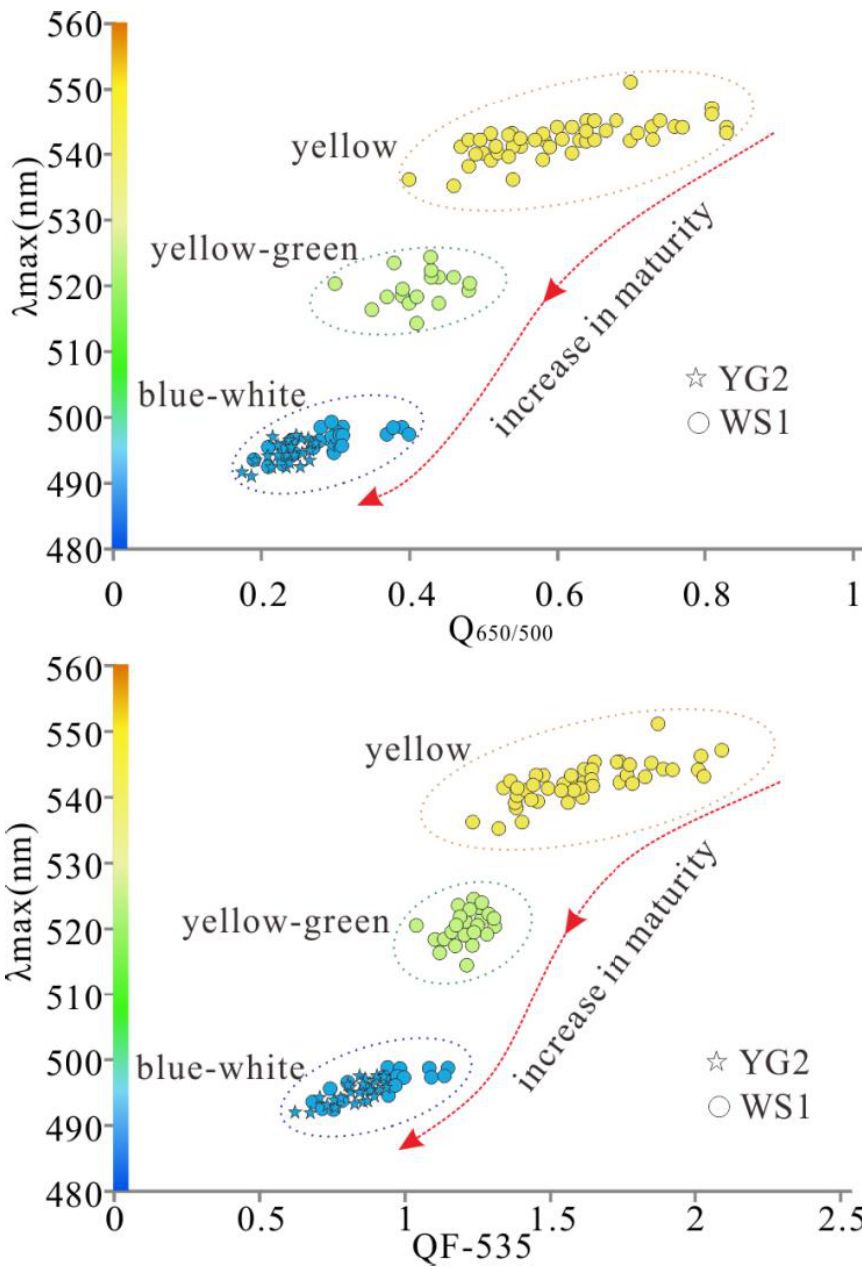
Figure 12. Cross plots between the fluorescence parameters (λ max , Q 650/500 , QF-535) of petroleum inclusions in the Permian reservoirs of the Wumaying buried hill.